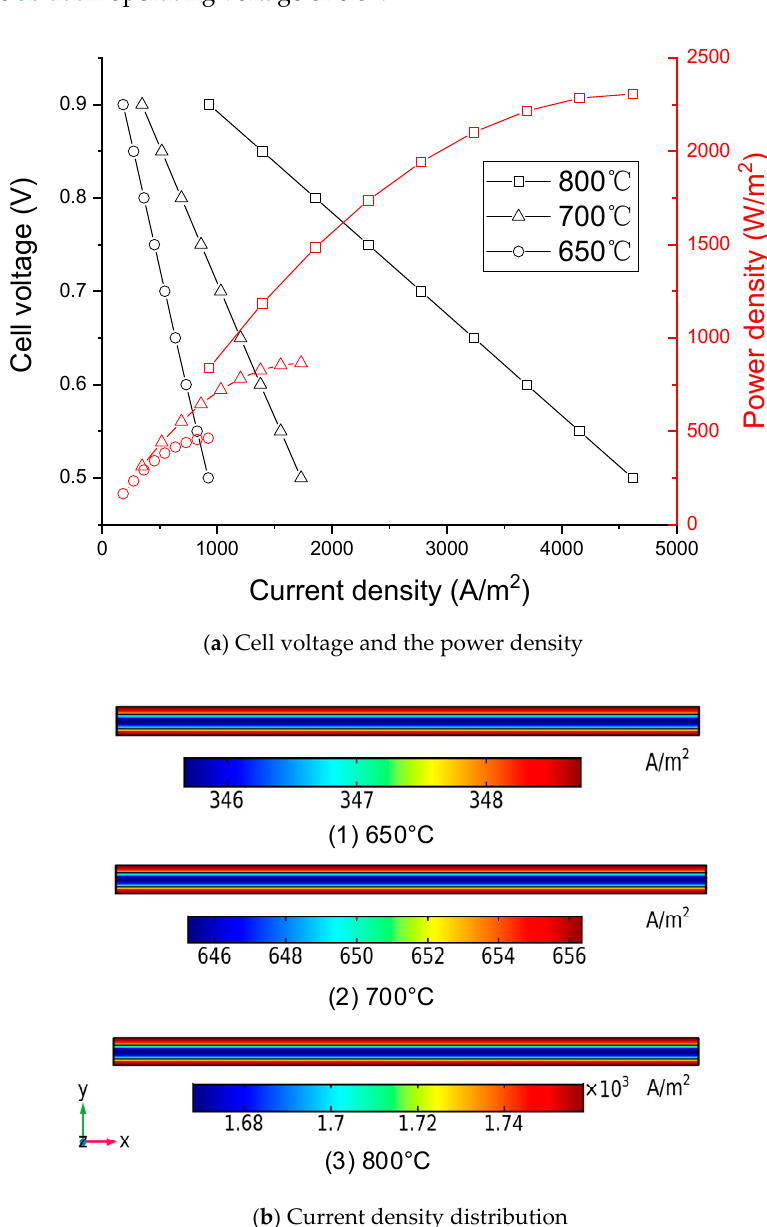
Figure 3. Comparison between two cases with di ff erent operating